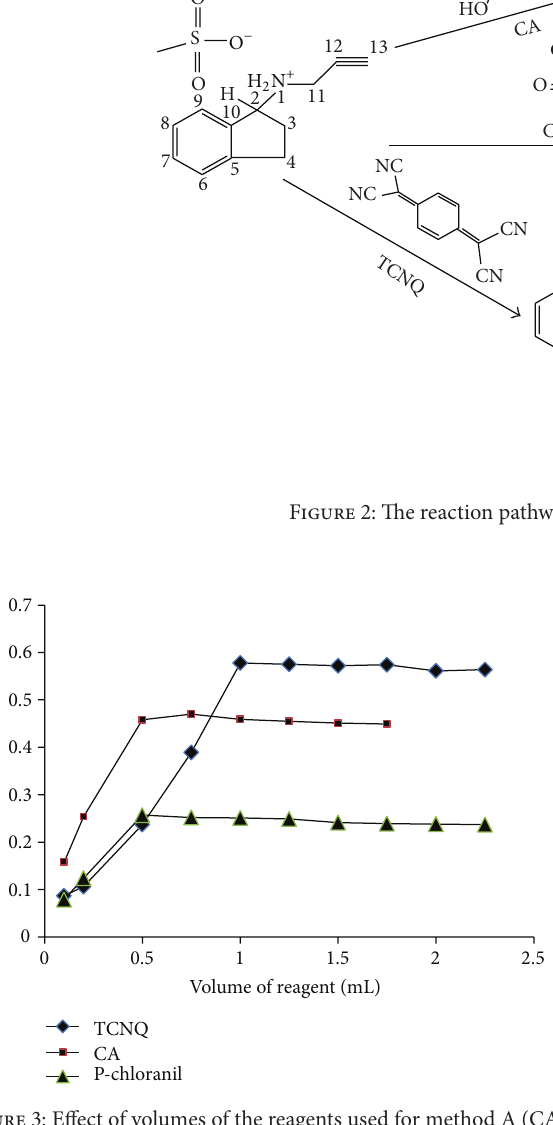
Figure 4: The effect of time on the reaction for methods A, B [ Q , at room temperature], and C [ ◼ , at 80 ∘ C] with the drug substance